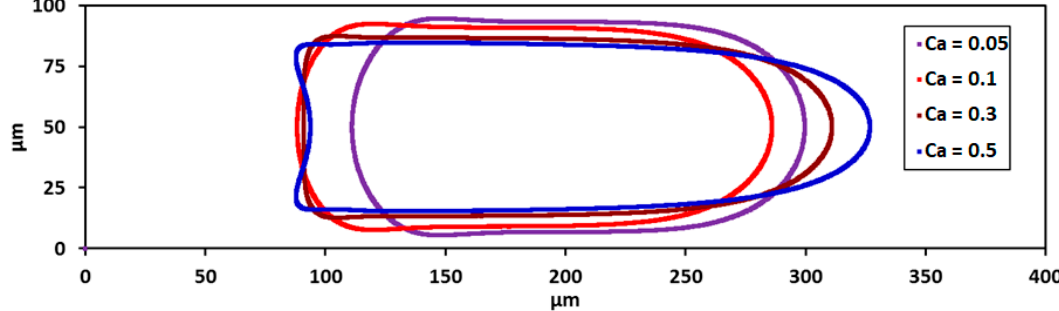
Figure 8. Shape of the interface of the droplet at various 𝐶𝑎 values.